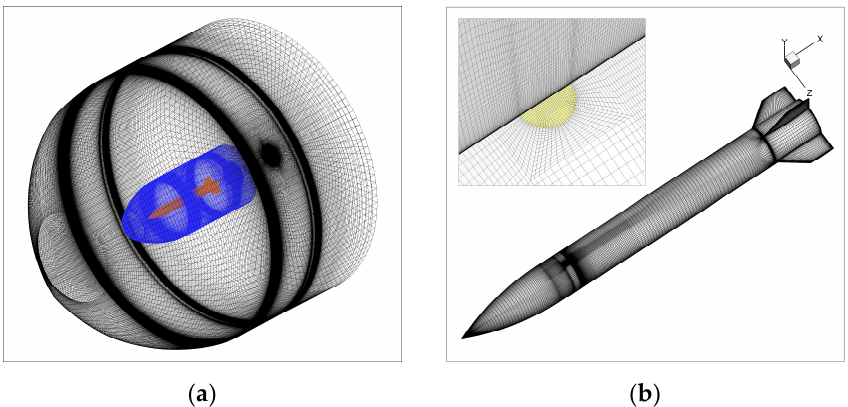
Figure 3. Computational grids for AFF: ( a ) Computational domain; ( b ) surface grid of body-fin configuration.